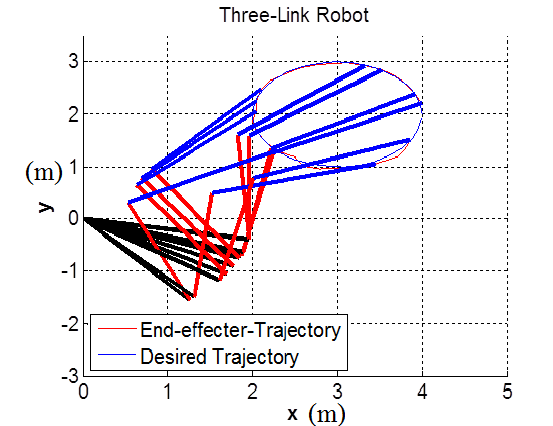
Fig. 7. The three link robot end effecter and the desired circular trajectories.